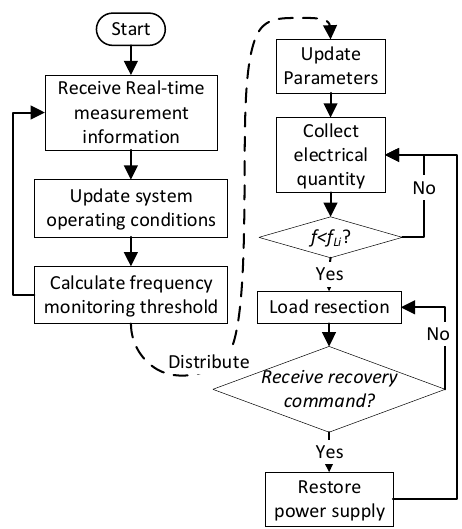
Figure 11. Control scheme of active load shedding (ALS) in the proposed DR system.